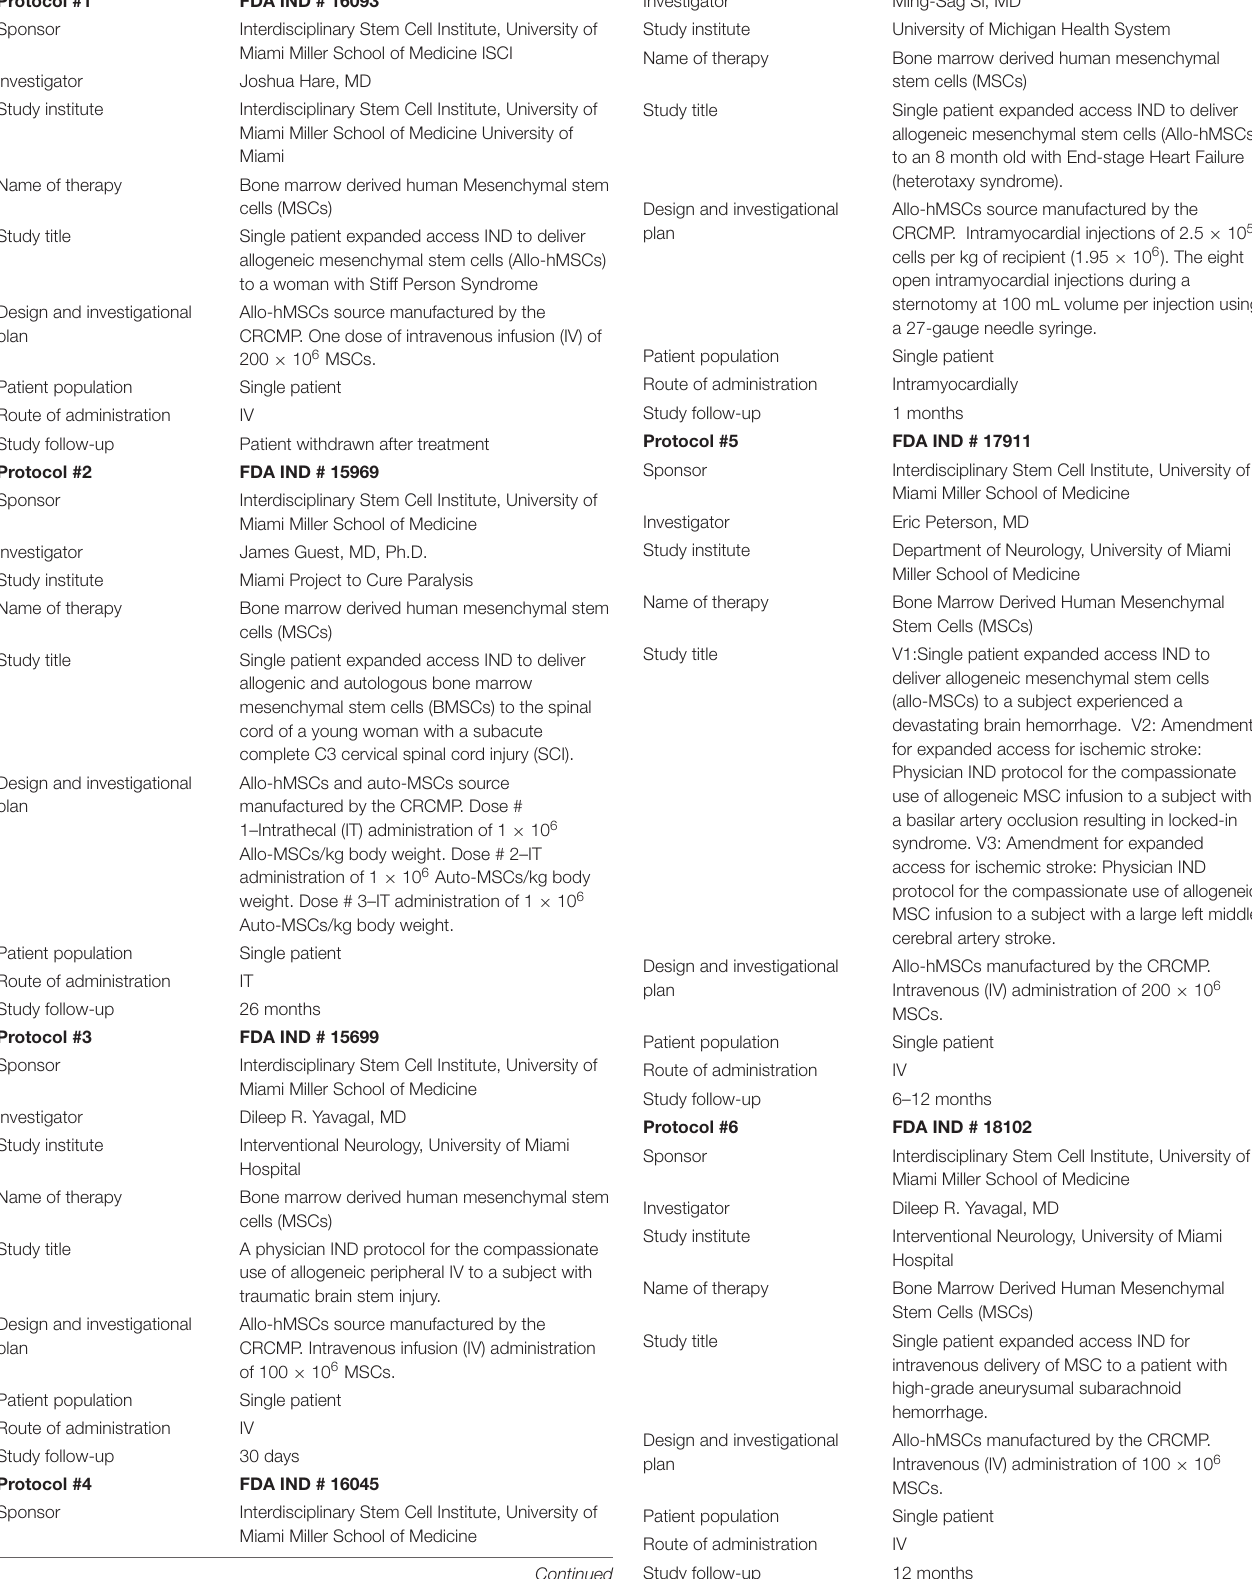
TABLE 5 | Outline of single patient INDs investigating mesenchymal stem cells. Protocol